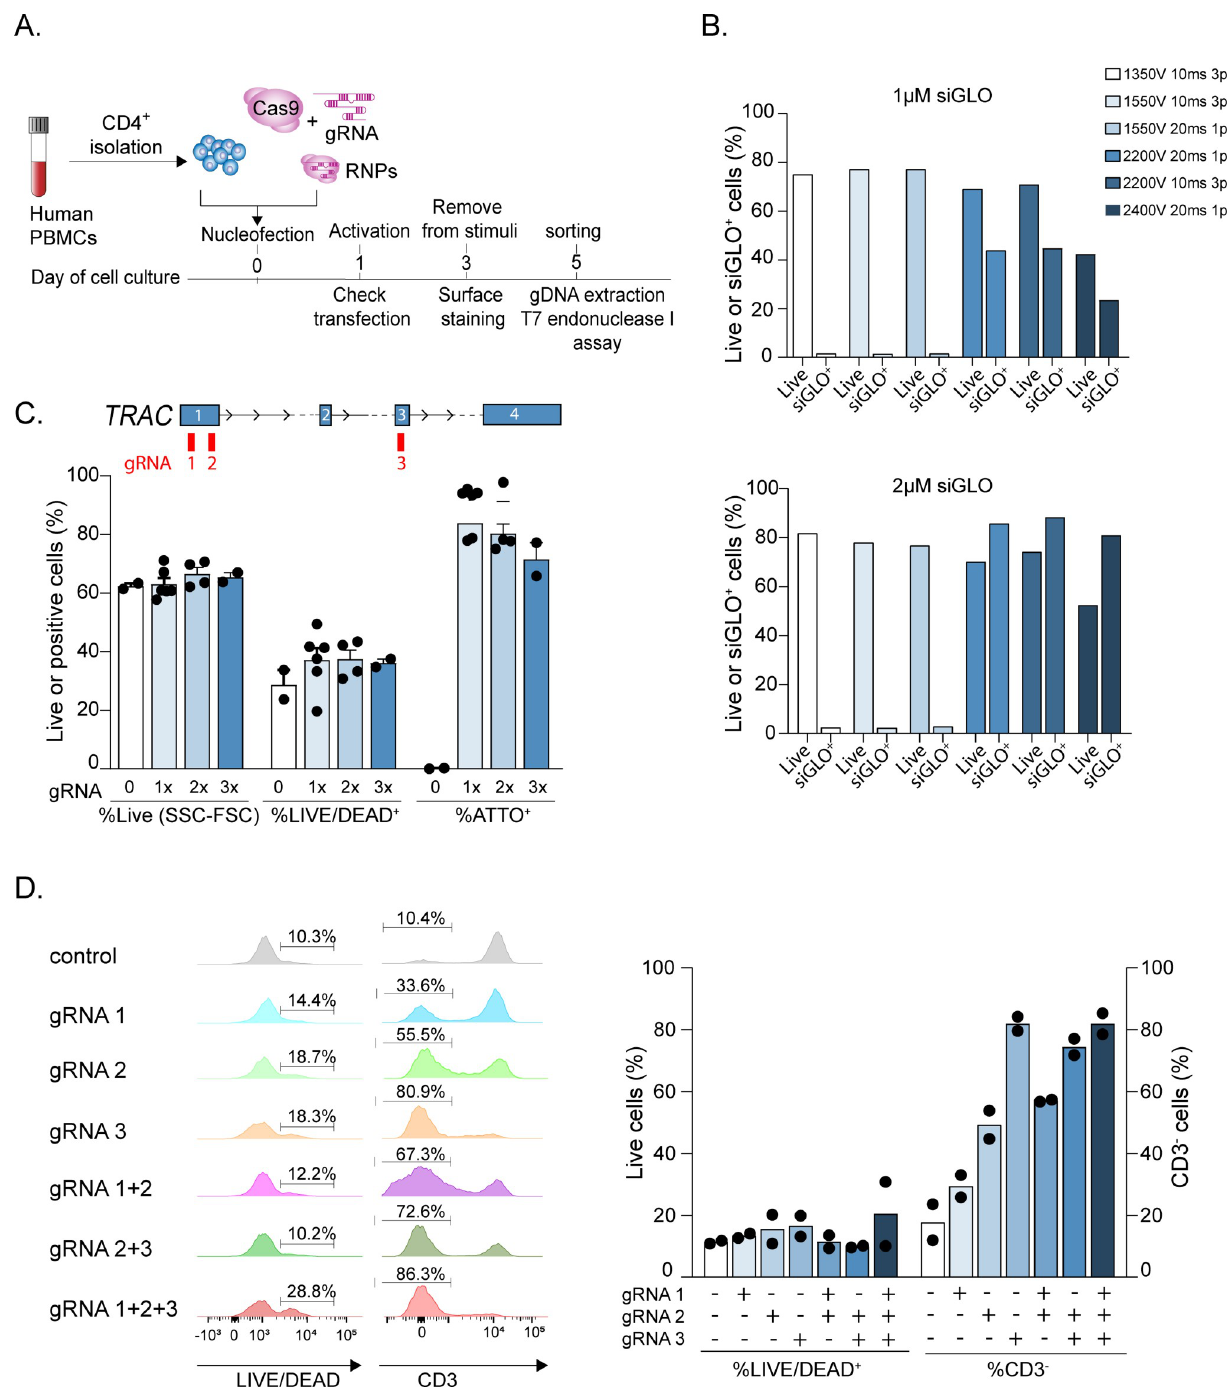
Fig 1. Optimization of transfection conditions for gene editing in primary human T lymphocytes. (A) Overview of the experimental workflow, including T cell isolation from the peripheral blood, RNP transfection, cell activation, sorting and downstream analyses. (B) Primary human memory T lymphocytes were transfected with 1–2 μ M of fluorescent siGLO oligonucleotide using the indicated Neon settings. 24 h after transfection cell viability and efficiency of siGLO incorporation were determined by flow cytometry (n = 1). (C) Resting primary memory human T lymphocytes were transfected with Cas9 RNPs including one, two or three different sgRNAs against the same gene ( TRAC ) and the optimized Neon settings (2200V 20ms 1 pulse). The position of the gRNAs relative to the TRAC gene is indicated in the scheme on top. Blue numbered rectangles indicate exons. 24 h after transfection the percentage of cell death was assessed by live-dead staining. The percentage of alive cells as assessed by gating on the side and forward scatter parameters (SSC, FSC) is also indicated. The efficiency of transfection was measured based on the incorporation of a fluorescent tracrRNA (ATTO + ) (n = 2–6). (D)